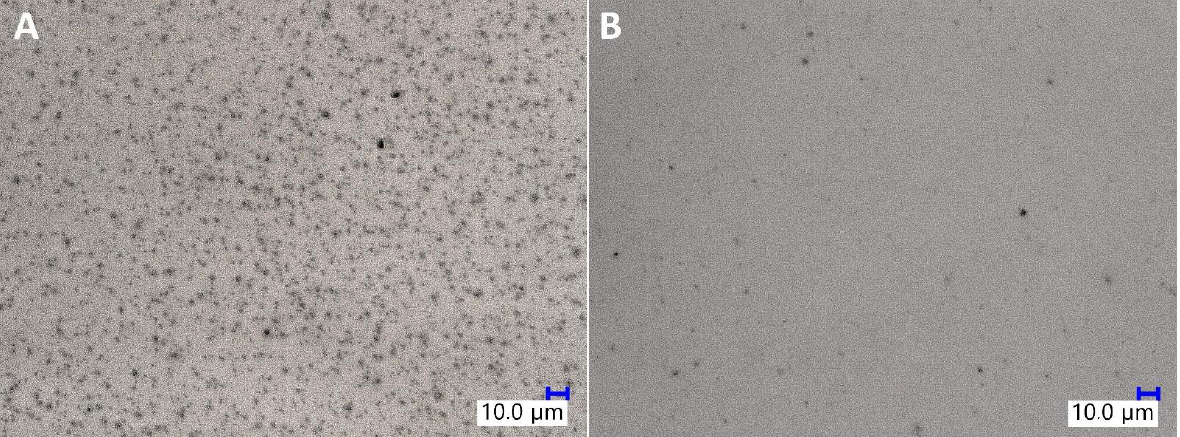
Figure 9. Digital optical microscopic images of neat TiO 2 /EP ( A ) and 1.5% i Bu 7 SSQ-OEt TiO 2 /EP ( B ).